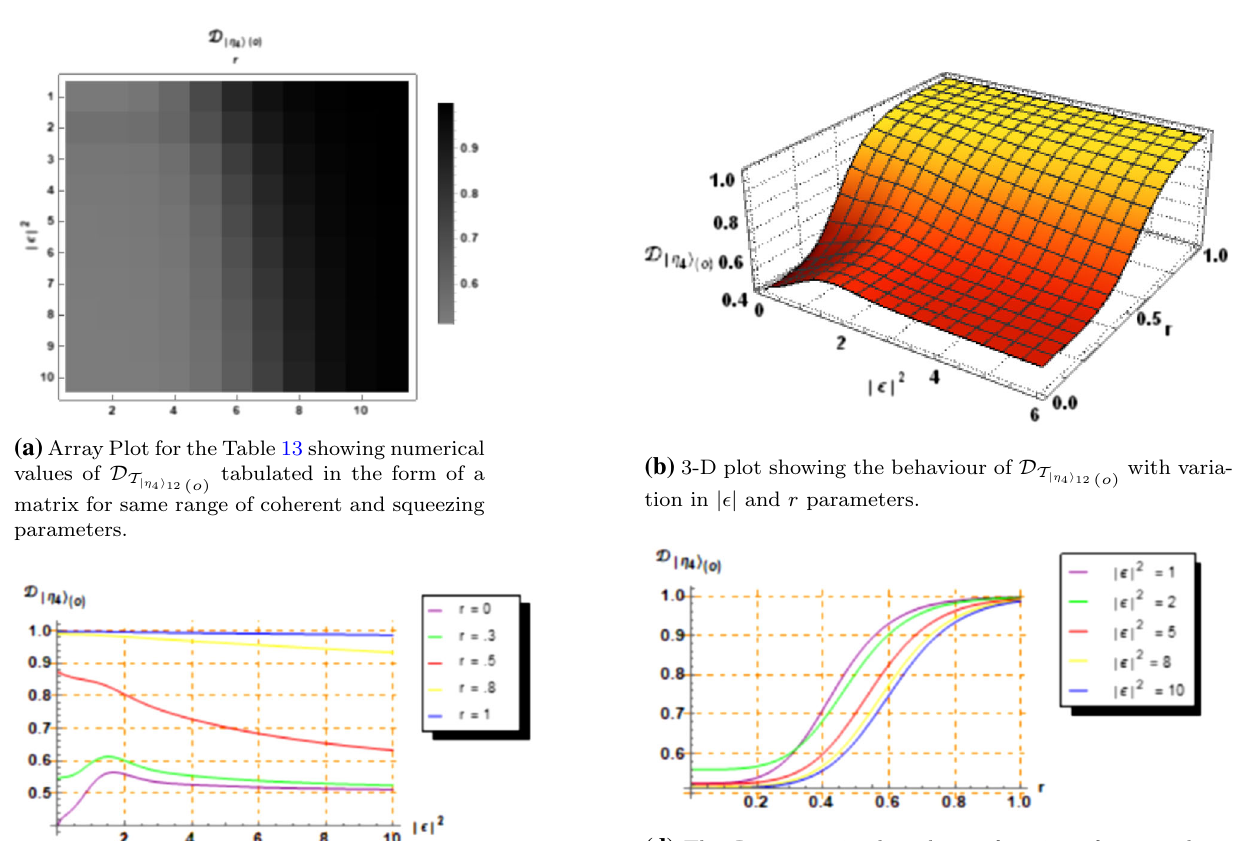
(d) The D T is plotted as a function of squeezed pa- | η 4 (cid:2) 12 ( o ) rameter for fixed values of coherent parameters. Here, with the increasing values of squeezed parameter the nonclassi- cal character of the | η 4 (cid:2) states increases and we may regard (cid:3) 1 for only r (cid:3) 1. Moreover, with the increasing D T | η 4 (cid:2) 12 ( o ) value of (cid:2) parameter the extend of validity of the semiclassical approximation with the increasing magnitude of r increases, however for r still smaller than unity.